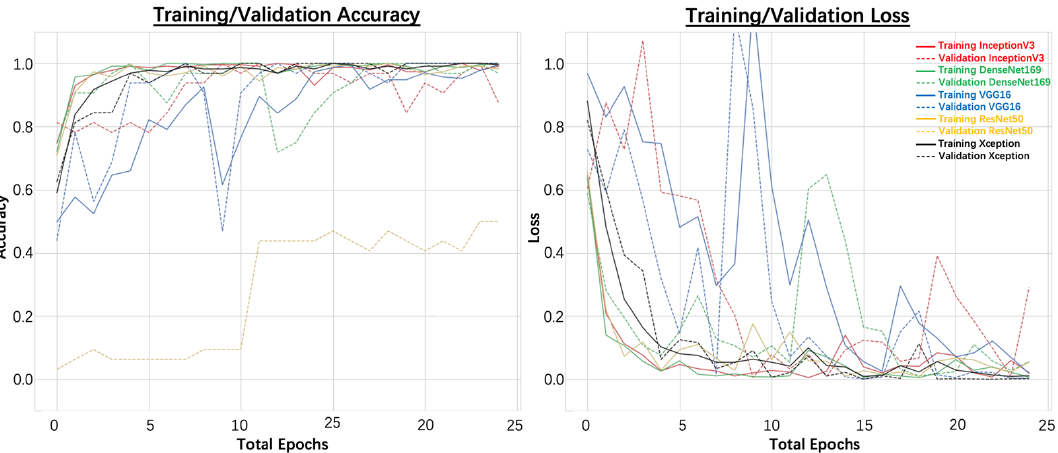
Figure 4. Training and validation accuracy and loss plots for training deep learning models to identify diseased regions using tile segments of size 250 × 250 pixels.